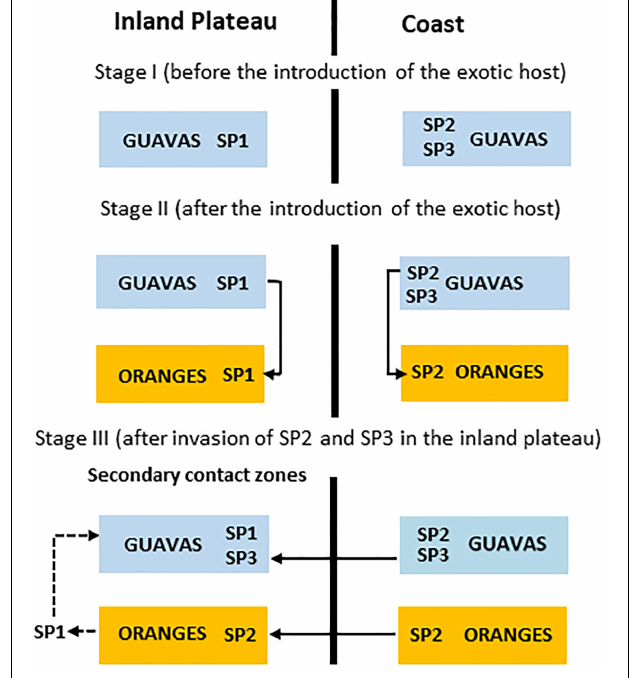
FIGURE 9 | Hypothesis on the contemporary pattern of host fruit usage by the AF complex species in eastern Brazil. In stage I, A . sp.1 is the resident species in Inland Plateau while A . sp.2 and A . sp.3 are residents at the Coast; Stage II, the colonization of exotic fruit by A . sp.1, A . sp.2 and A . sp.3; Stage III, the secondary contact zone for the three species after invasion of populations from the coast to the inland